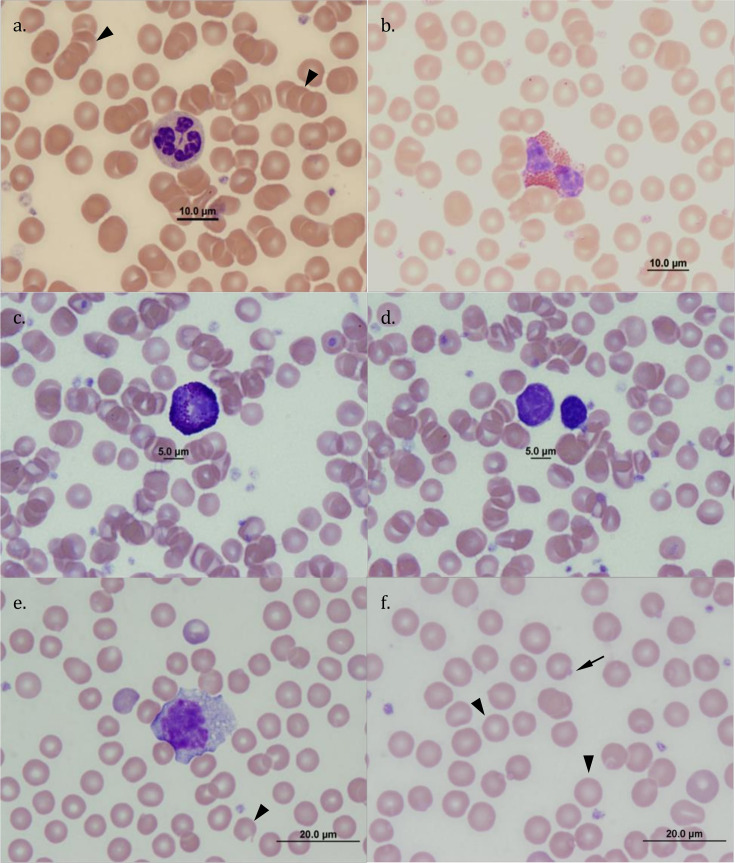
Photomicrographs of reference leukocytes and red blood cells observed in blood smears of quokkas on Rottnest Island and the mainland of Western Australia.(a) neutrophil, key features: polylobated nucleus with 3–6 lobes, coarsely clumped chromatin, primary cytoplasmic granules -azurophilic-; also present, atypical arrangement of erythrocytes: Rouleaux formation (arrowheads); (b) eosinophil, key features: polylobated nucleus with 2–3 lobes, coarsely clumped chromatin but less dense than neutrophils, prominent secondary eosinophilic cytoplasmic granules; (c) basophil, key features: intense secondary basophilic cytoplasmic granules; (d) lymphocytes, key features: darkly staining chromatin with no apparent nucleolus, cytoplasm presents as a “rim” and appears finely or coarsely granular, nuclear:cytoplasm (N:C) ratio smaller than that of other leukocytes; (e) monocyte, key features: indented to irregularly shaped nucleus, reticular chromatin, large amount of pale, grey to basophilic cytoplasm, often with vacuoles, overall size of the cell is greater than all other leukocytes; a keratocyte (i.e. poikilocyte; arrowhead) is also present; (f) erythrocytes with normal morphology (arrowheads), and with erythtocytic inclusions (e.g. Heinz body -arrow-). All photomicrographs: original magnification x1000-, staining Wright-Giemsa.